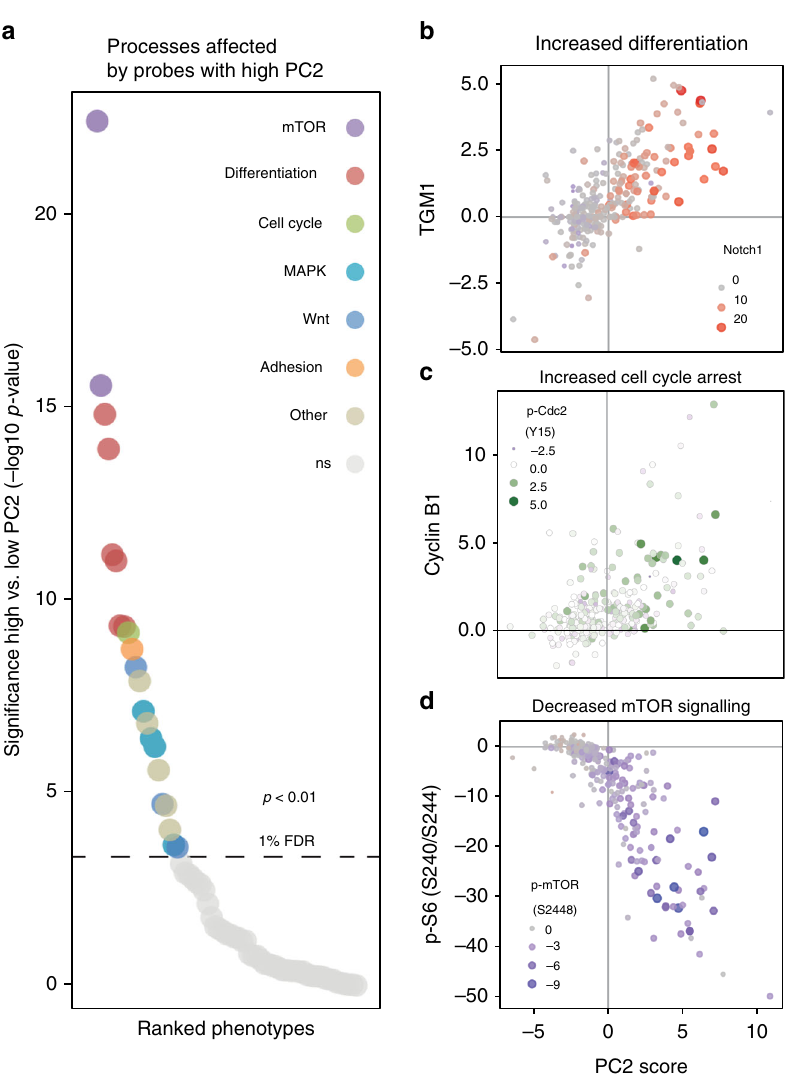
Fig. 3 Probes with high PC2 affect differentiation, cell-cycle arrest and mTOR signalling activity. a Summary of signi fi cantly ( p < 0.01, FDR 1%, t -test, Supplementary Fig. 17) affected molecular phenotypes from probes with high PC2 (top 10%) compared to low PC2 (bottom 10%). b Scatterplot illustrating probes with high PC2 score ( x -axis) have increased TGM1 and NOTCH1 levels measured by ID-seq. c Scatterplot illustrating probes with high PC2 score ( x -axis) have increased cell-cycle arrest marker (Cyclin B1 and p-cdc2) levels measured by ID-seq. d Scatterplot showing the probes with high PC2 score ( x -axis) strongly have decreased phospho-S6 and phospho-mTOR levels illustrating decreased mTOR signalling activity measured